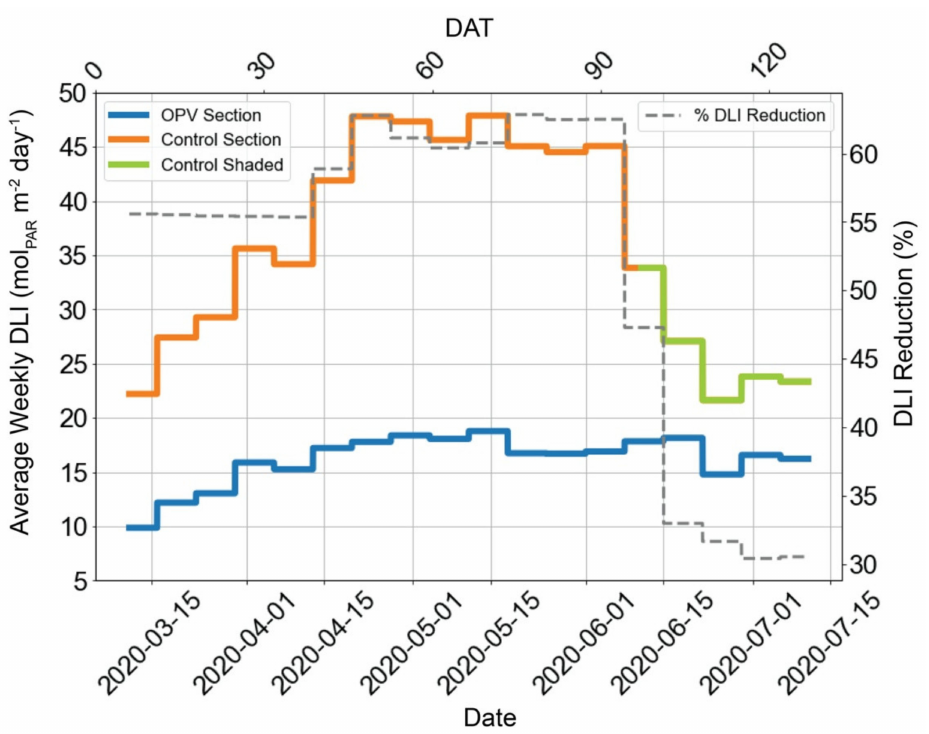
Figure 8. Estimated weekly averages for the daily light integral (DLI, in mol PAR m − 2 day − 1 ) in OPV and Control sections with corresponding dates and days after transplant (DAT).